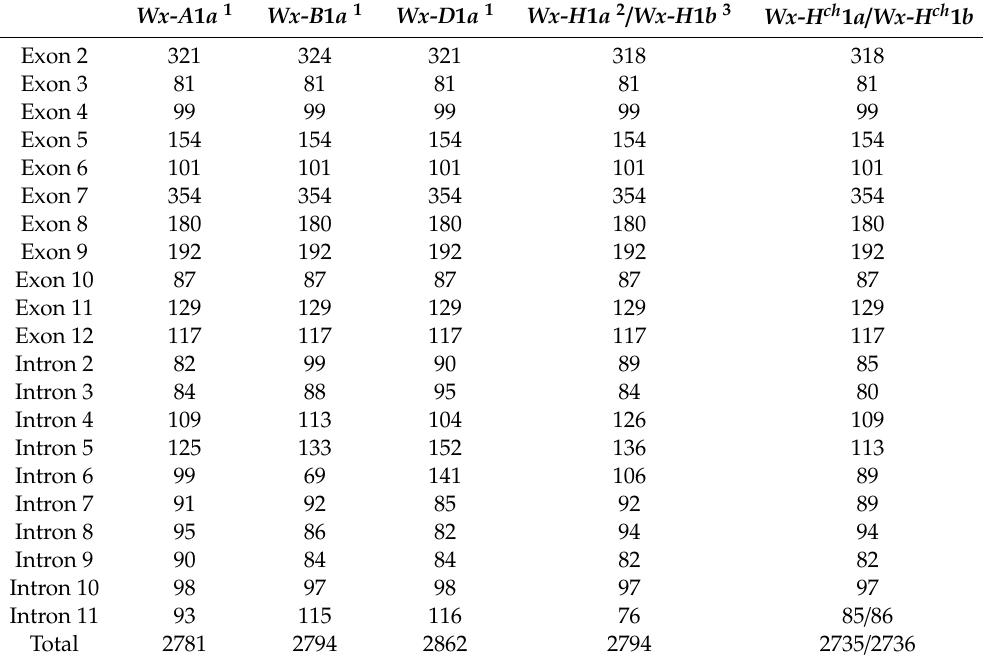
Table 1. Size of the di ff erent exons and introns of the coding sequence in the Wx sequences